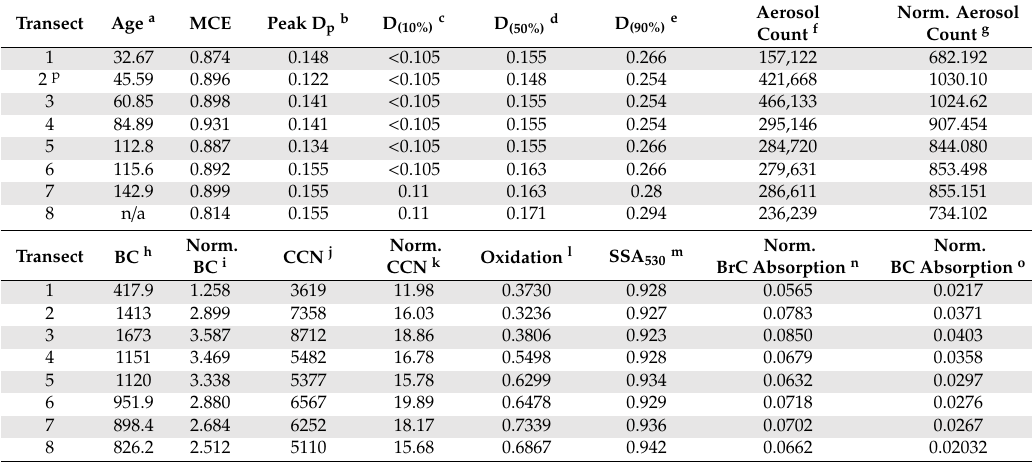
Table 2. Aircraft-measured particle properties, averaged by transect. Norm.– CO-normalized.